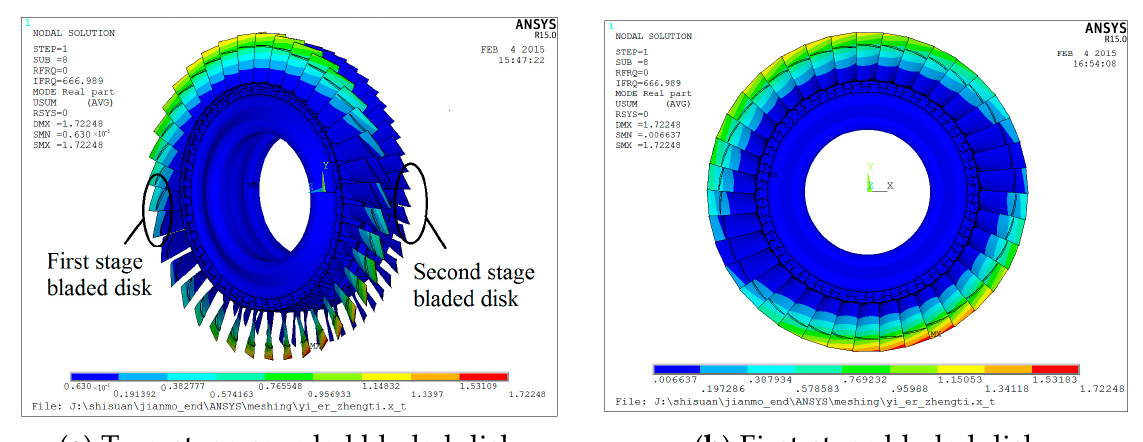
Figure 15. One-pitch coupled vibration of the blade and disk.